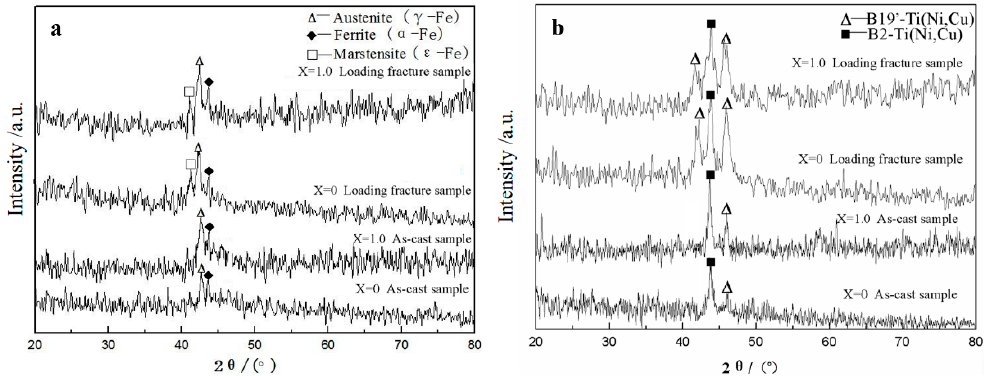
Figure 2. X-ray diffraction patterns of ( a ) Fe 65.4 − x Ce x Mn 14.3 Si 9.4 Cr 10 C 0.9 and ( b ) Ti 40 − x Ce x Ni 40 Cu 20 (x = 0, 1.0) alloys.